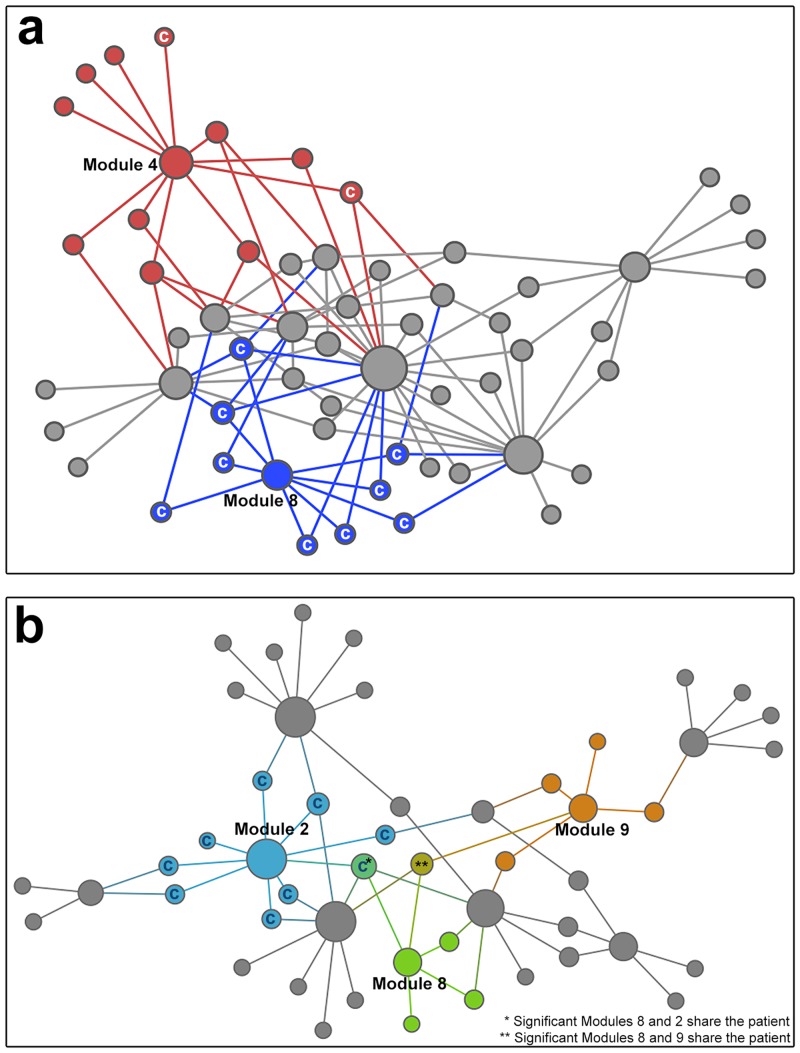
Network analysis of cases and controls.Cases are labeled by letter “c” in the significant modules. (A) Network of all modules of the exome library and patients, with the patients from significant Modules 4 and 8 highlighted in red and blue, respectively. (3B) Network of all modules of the haplotype block library and patients, with the patients from significant Modules 2, 8 and 9 highlighted in light blue, green and orange, respectively.